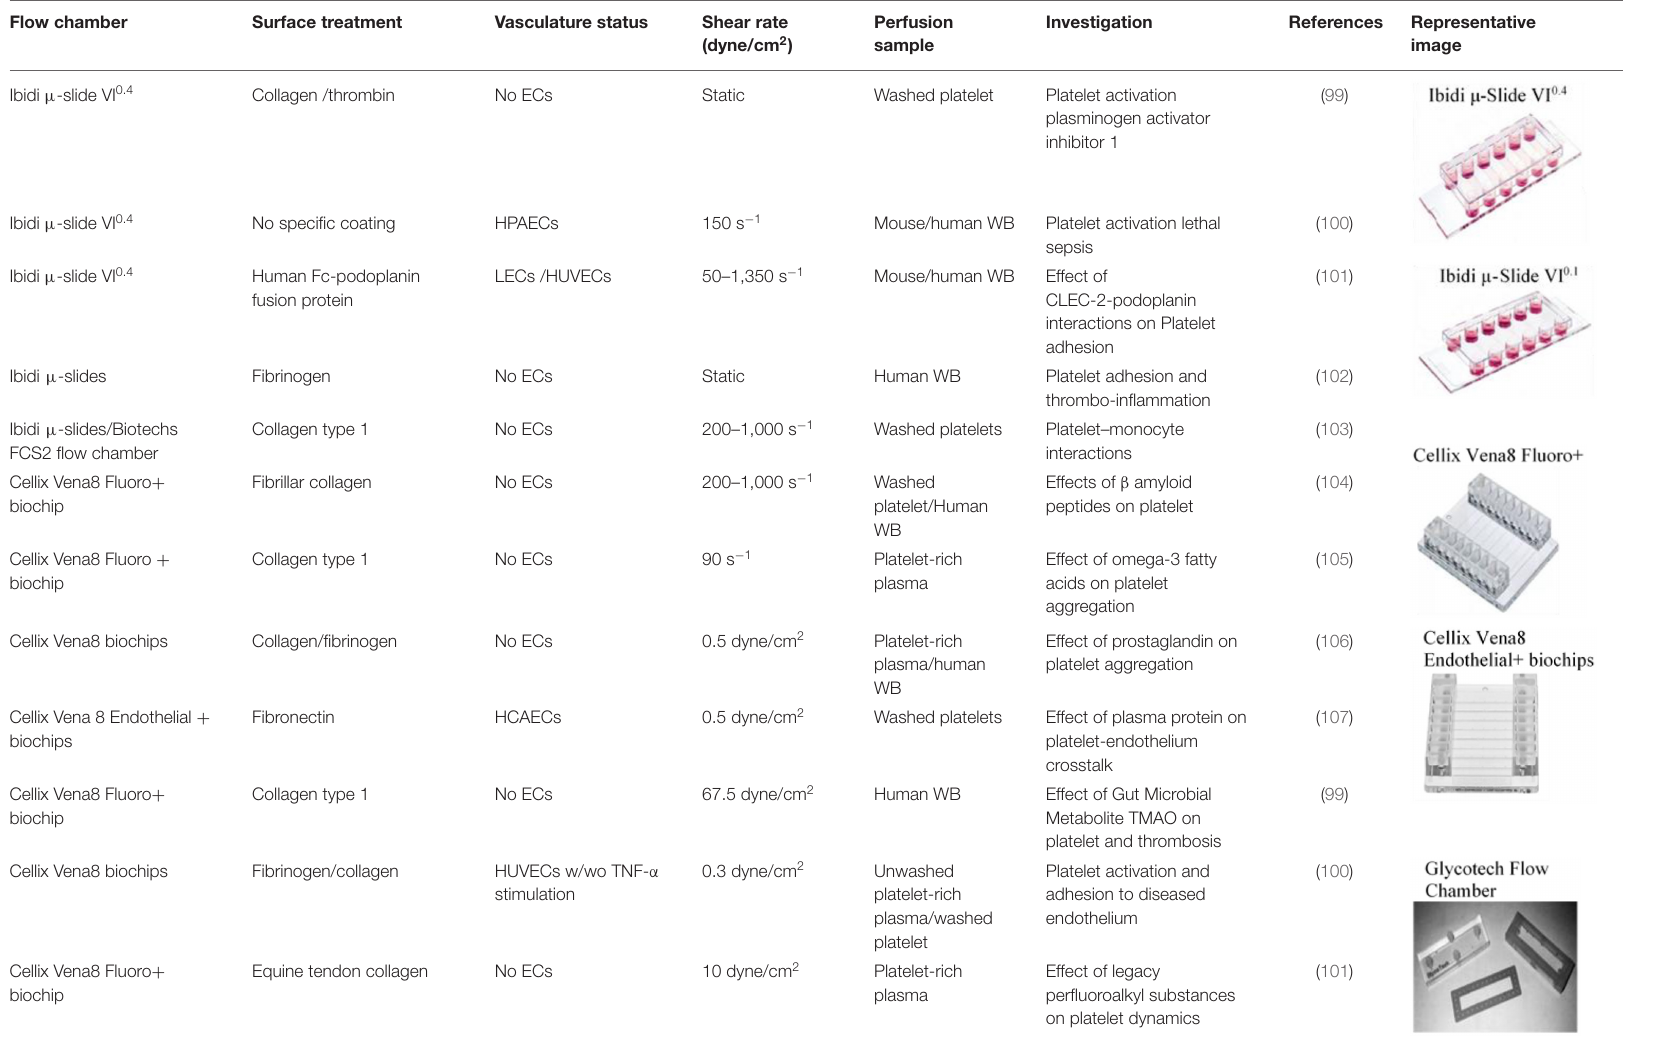
TABLE 2 | Commercialized microfluidic slides for laboratory